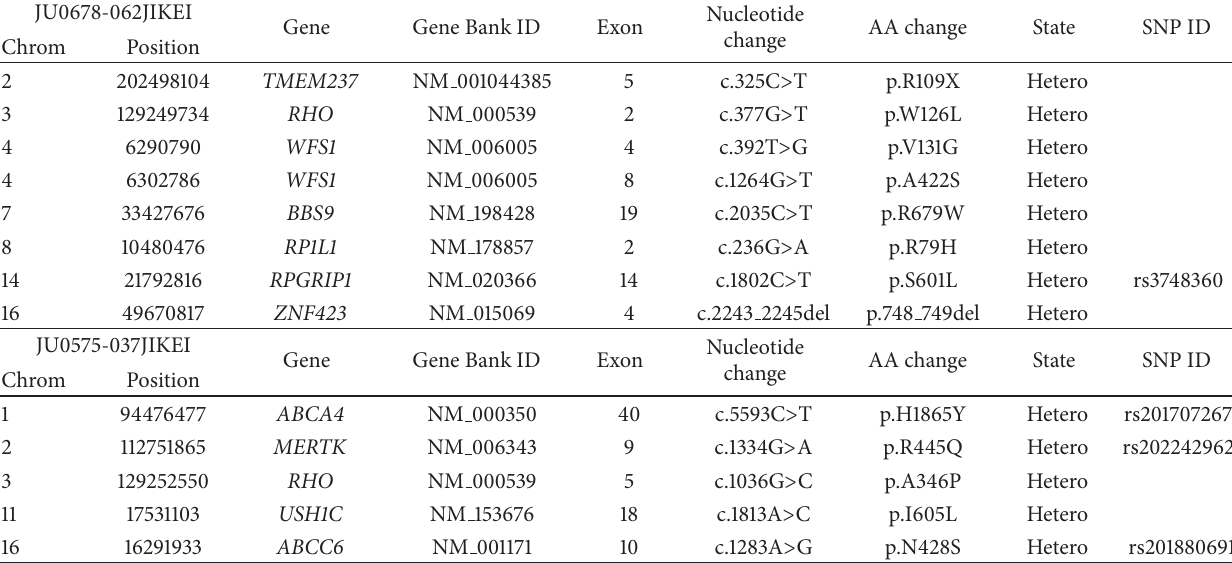
Table 1: The rare variants found in the two Japanese families with RHO mutations, focusing on 212 retinal disease-causing genes registered in the RetNet database (https://sph.uth.edu/retnet/).